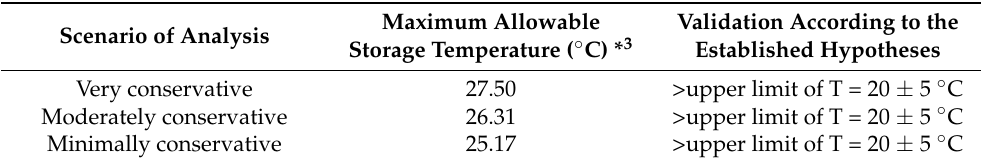
Table 6. Prediction of the maximum allowable storage temperature according to the Arrhenius